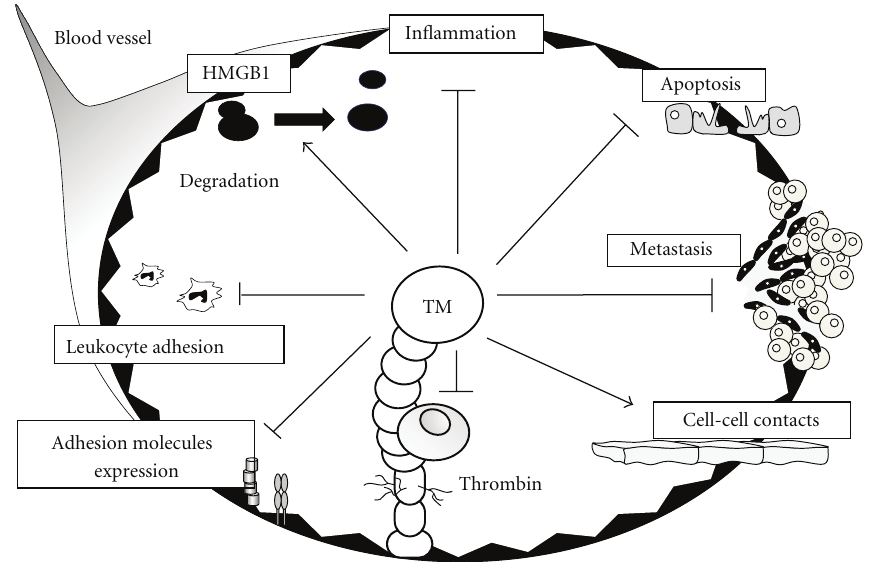
Figure 2: Multiple roles of TM in the maintenance of vascular homeostasis. TM inhibits inflammation, apoptosis, tumor metastasis, thrombin function, adhesion molecule expression, and leukocyte adhesion. Proinflammatory high-mobility group box 1 (HMGB1) is neutralized and degraded by